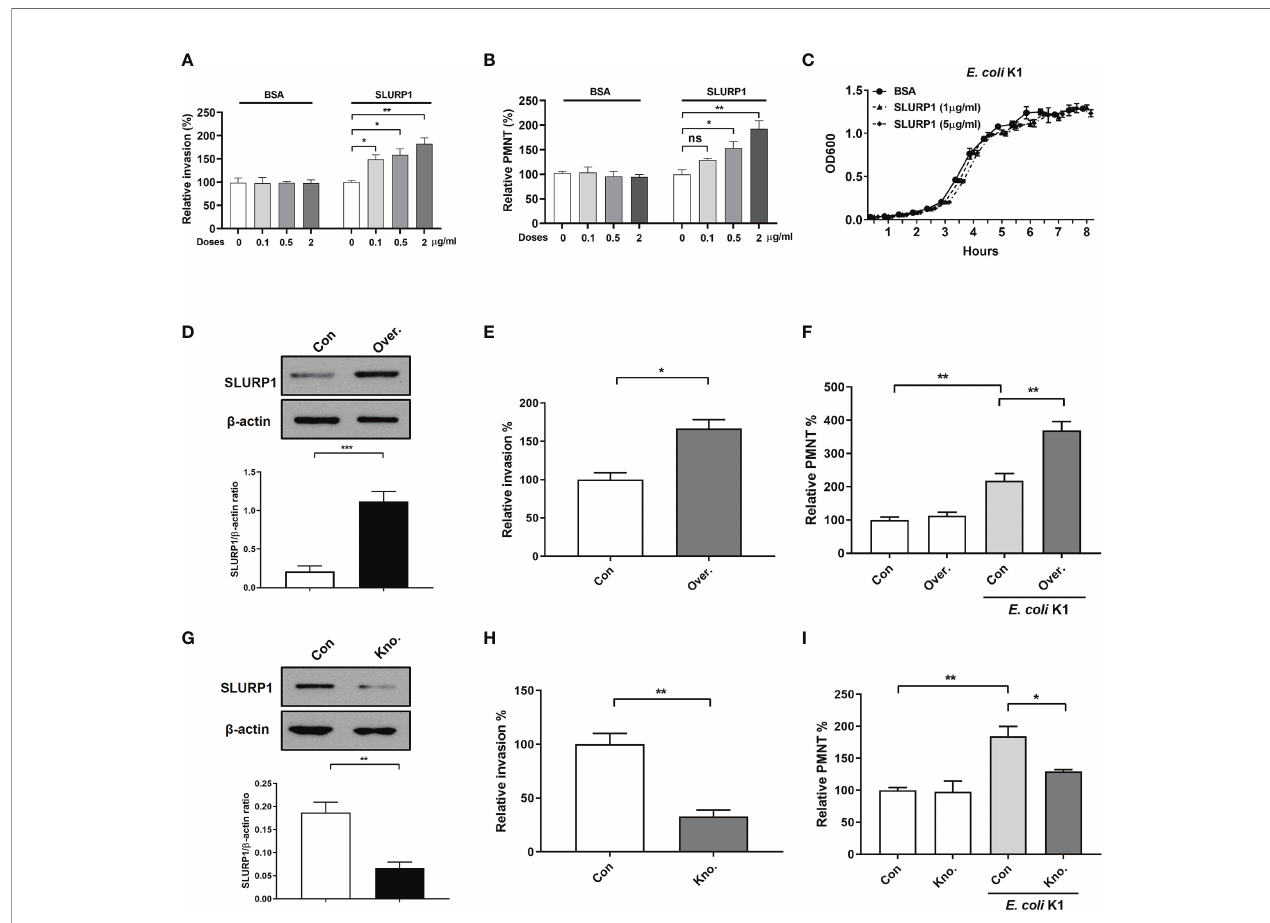
FIGURE 2 | The effect of SLURP1 on E coli K1 penetration and PMN transmigration across the BBB in vitro . (A) The invasion of E coli K1 into HBMEC which pretreated with indicated doses of BSA or SLURP1. Data are presented as percent of the control values. (B) Transwell-cultured HBMEC monolayers were pre treatment with indicated doses of BSA or SLURP1 for 2 h, followed by incubated with E coli K1 in the bottom and PMN in the top of fi lter successively. PMN in the bottom of fi lter were harvested and counted. (C) The growth curve of E coli K1 in medium containing indicated doses of SLURP1. (D) The upregulation effect of SLURP1 in HBMEC which had been transfected with pCNDA3.1+-SLURP1. (E) The invasion of E coli K1 into HBMEC which had been transfected with pCNDA3.1 +-SLURP1. Data are presented as percent of the control values. (F) Effect of SLURP1 upregulation on E coli K1-induced PMN transmigration across the HBMEC monolayers. Data are presented as percent of the control values. (G) The knockdown effect of SLURP1 in HBMEC transfected with siRNA. (H) The invasion of E coli K1 into HBMEC which had been transfected with siRNA. Data are presented as percent of the control values. (I) Effect of SLURP1 knockdown on E coli K1-induced PMN transmigration across the HBMEC monolayers. Data are presented as percent of the control values. Over., overexpression; Kno., knockdown. The immunoblots results are representative of three independent experiments (D, G) . The data are displayed as the mean ± SEM from three independent